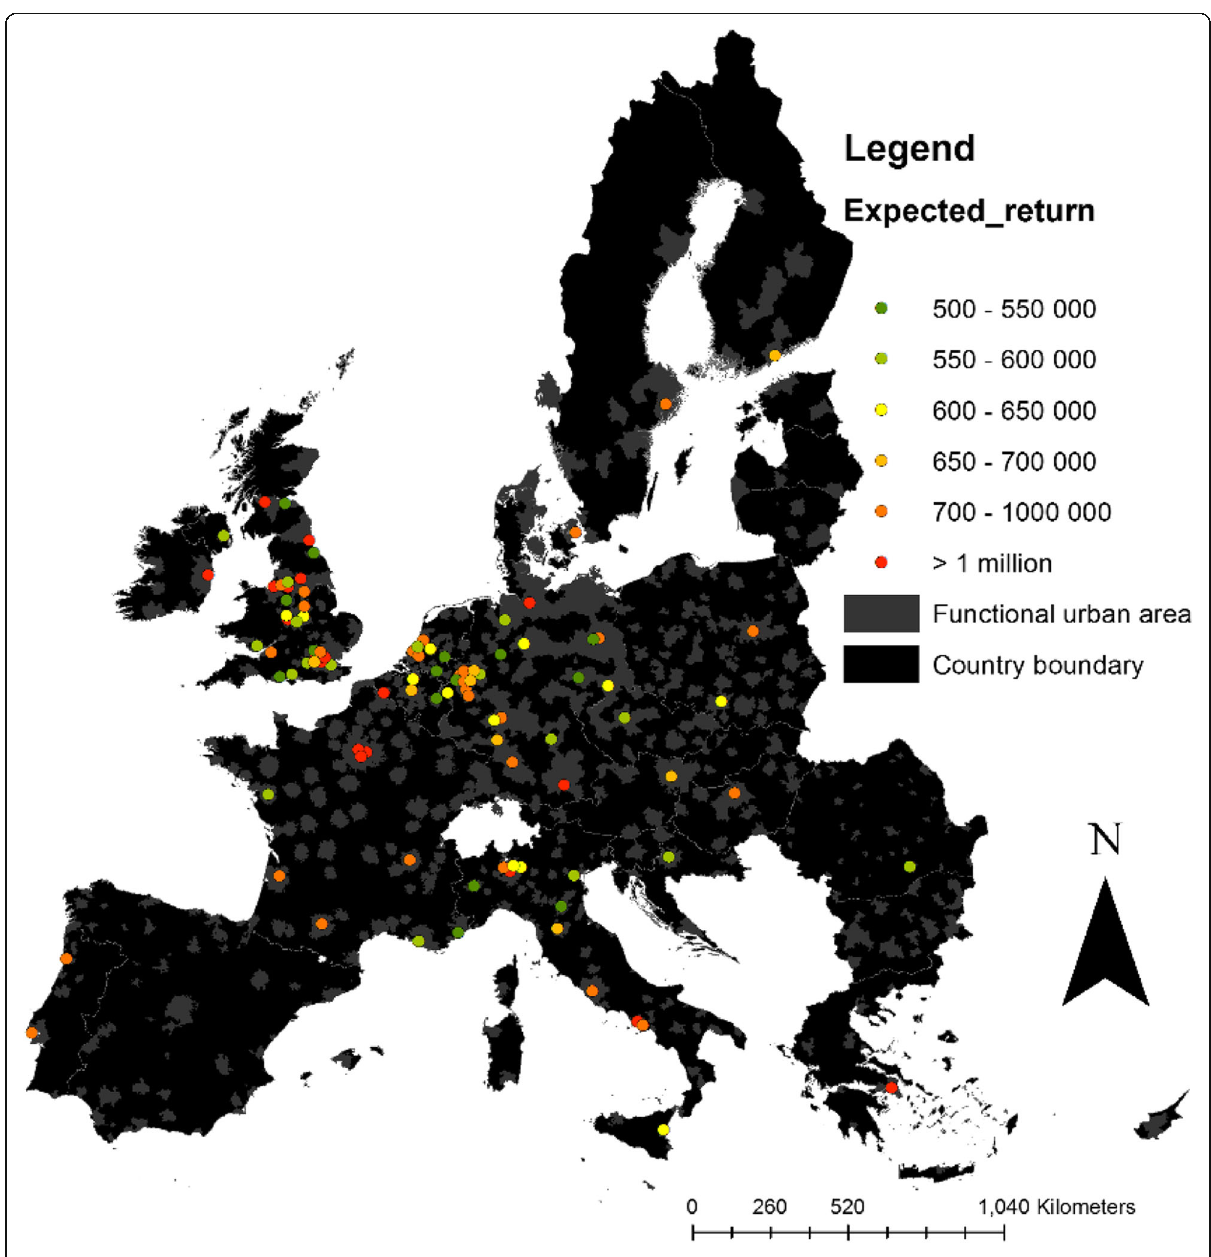
Fig. 12 Spatial distribution of hives for Scenario 2 under 6 different economic viability